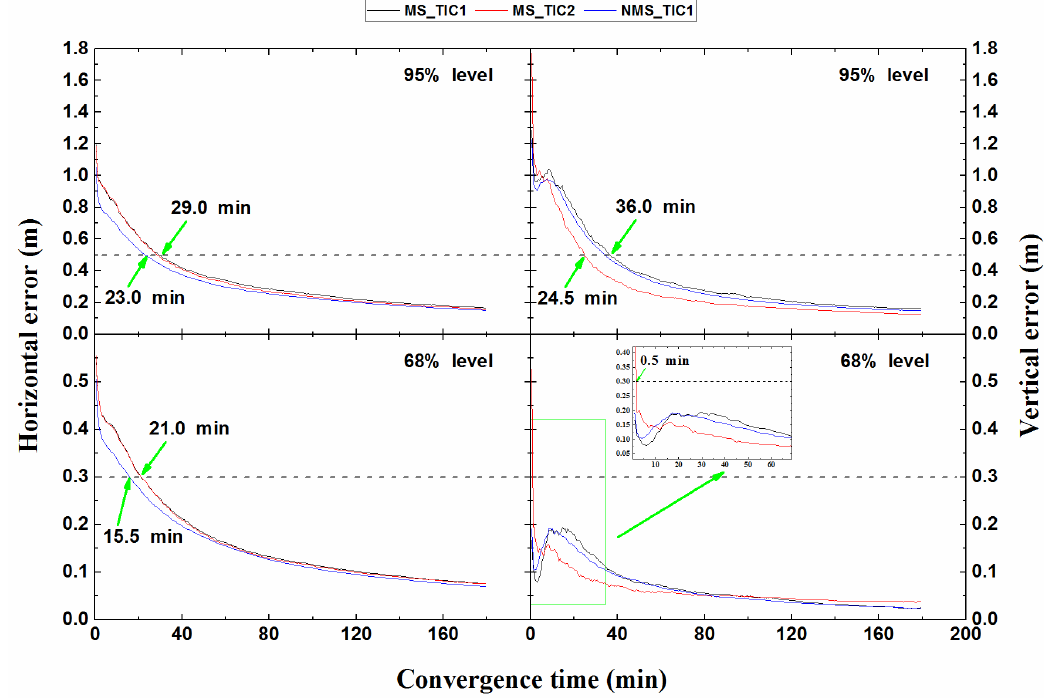
Figure 9. The GPS static SF PPP convergence performance in different constraint schemes during the MS and NMS periods. Table 6. The convergence times of GPS static and kinematic SF PPP in MS and NMS of TIC1 or TIC2. Scheme